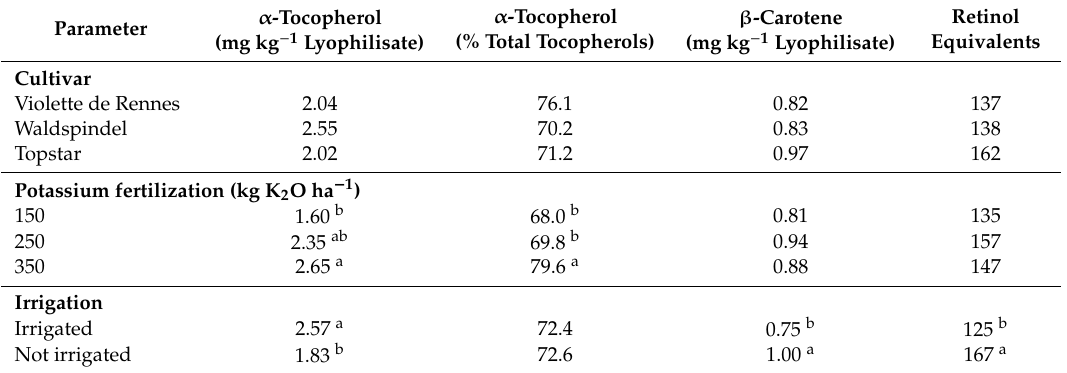
Table 3. The e ff ect of experimental factors on the vitamin content of Jerusalem artichoke